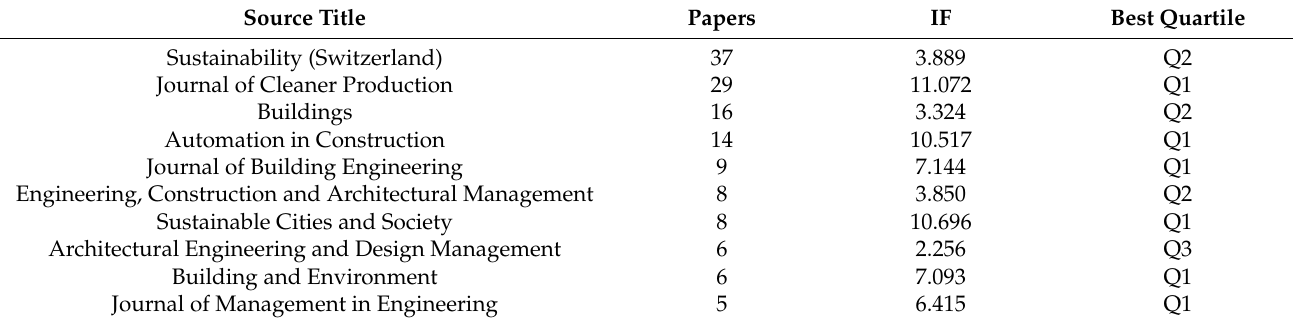
Table 5. Top ten journals ranked by the number of publications on C4.0 and